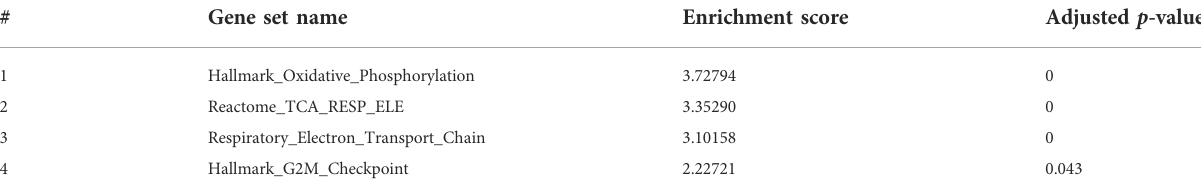
TABLE 2 Gene Set Enrichment Analysis (GSEA) of gne KO versus gne WT zebra fi sh at 3